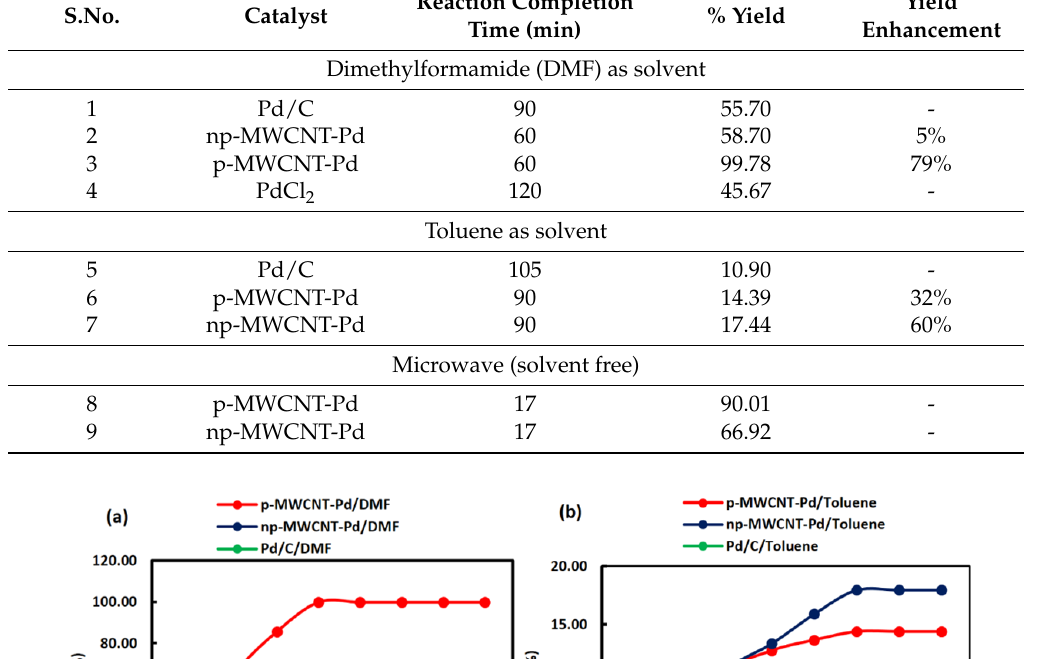
Isolated yields of all the reactions at completion. Analysis was done after recrystallization.